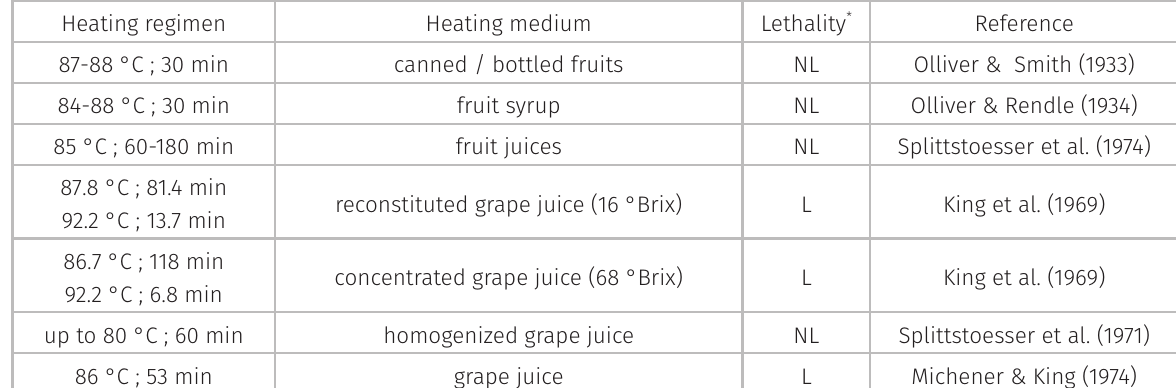
Table II. Thermal resistance of ascospores of Byssochlamys fulva depending on the heating regime in products based on grapes and other